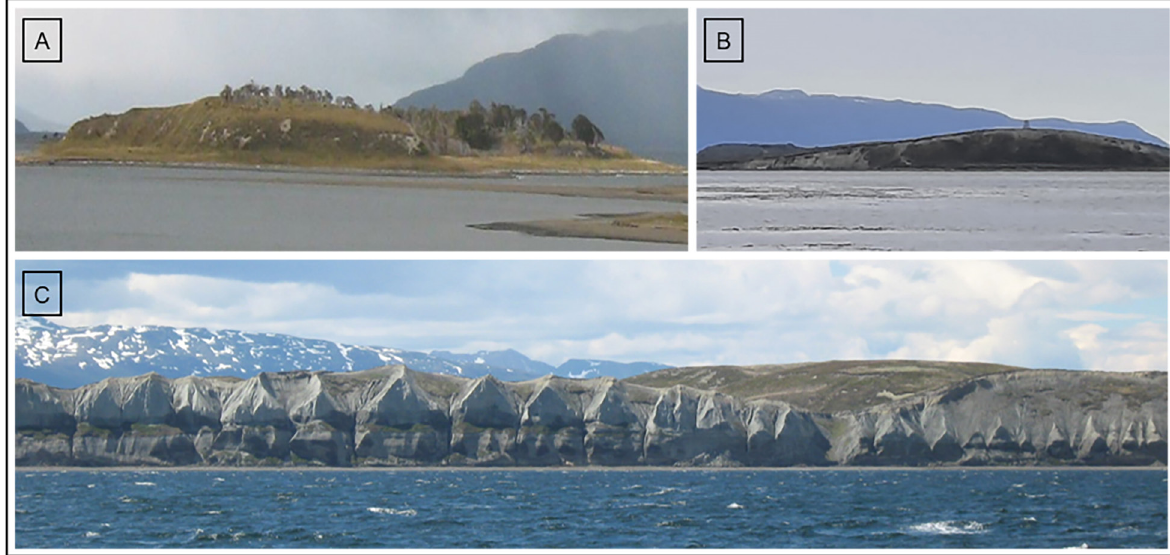
Fig. 12. Drumlins in the Beagle channel coasts. A and B – stream-lined depositional landforms in W–E direction; C – the Gable island wall formed by wave and runoff erosion at the western slope of drumlins, their internal composition can be seen by sailing or by binoculars from the coast. The name of the island refers to the architectural triangular shape, a very singular feature in the